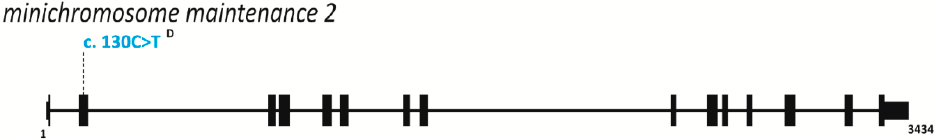
Figure 6. Minichromosome maintenance 2 heterozygous variant is linked to familial deafness. Exon and intron schematic was generated with the UCSD genome browser. Reference sequence is MCM2 NM_004526.4. Schematic of MCM2 gene is depicted with exons as black boxes and introns as horizontal lines. Missense mutation is mapped to the appropriate gene regions. “D” superscript indicates a heterozygous dominant mutation.